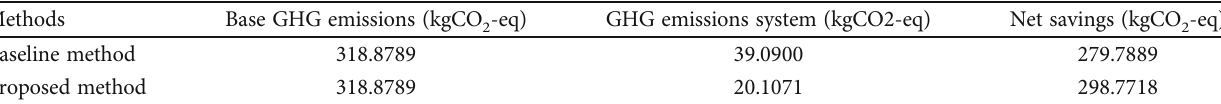
Table 5: GHG emissions and net saving